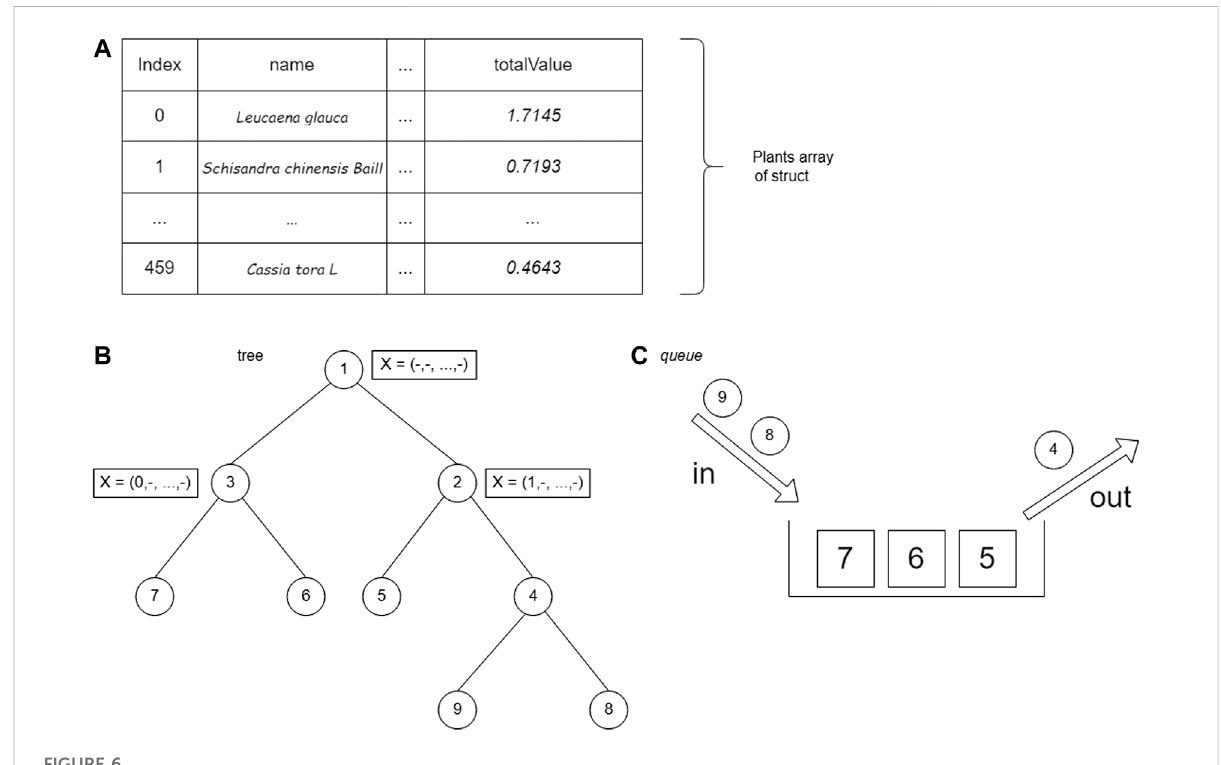
FIGURE 6 Use of the queue data structure in tree